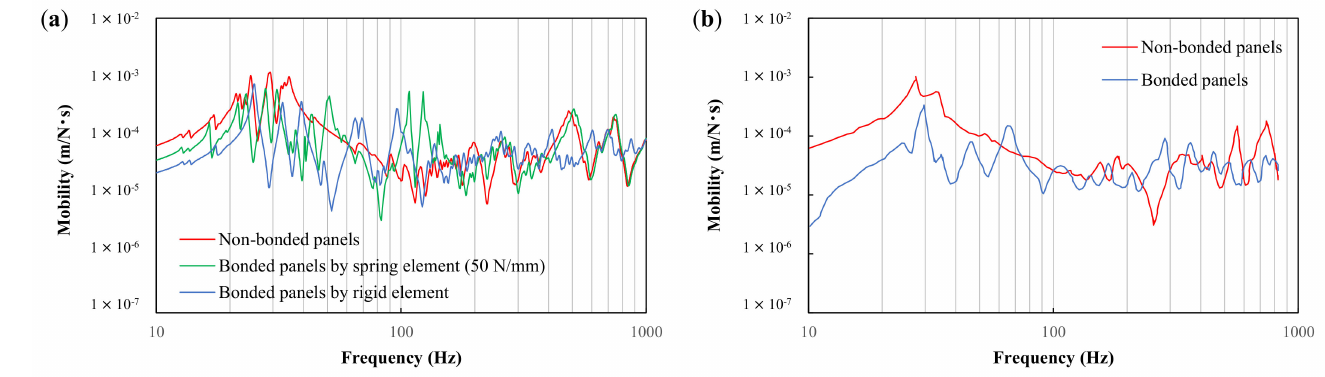
Figure 12. ( a ) Numerical result by the FEM in the present study; ( b ) measurement results from Sho et al. [44].